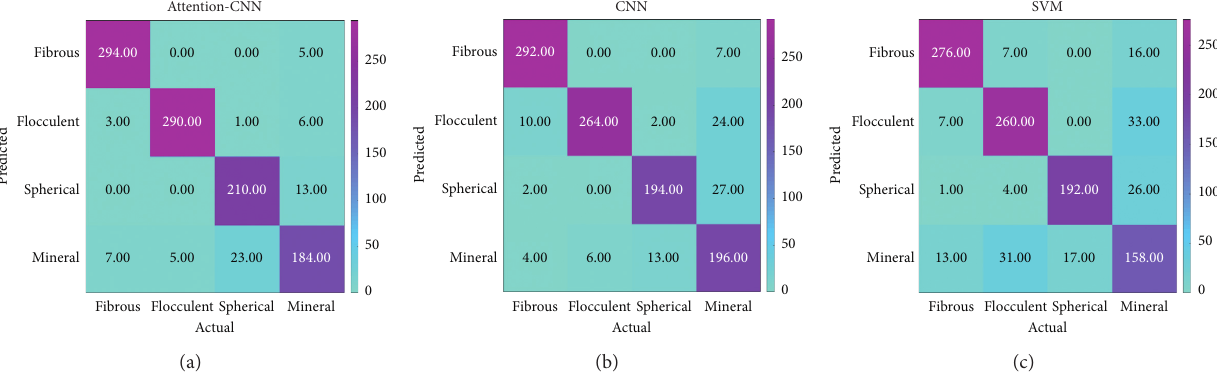
Figure 8: Confusion matrix for classification using Attention-CNN, CNN, and